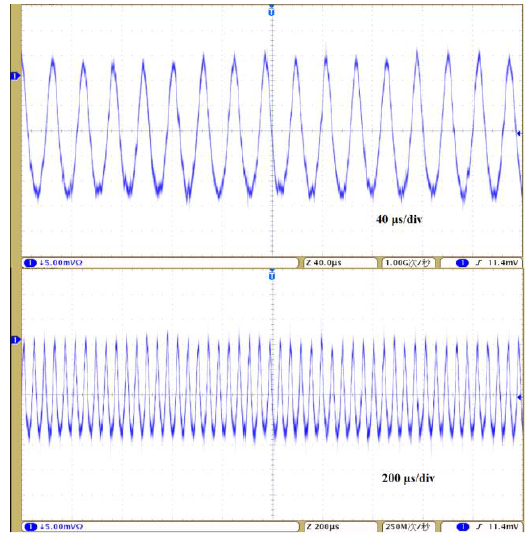
Figure 5. The pulse trains in 40 μs and 200 μs time scales.